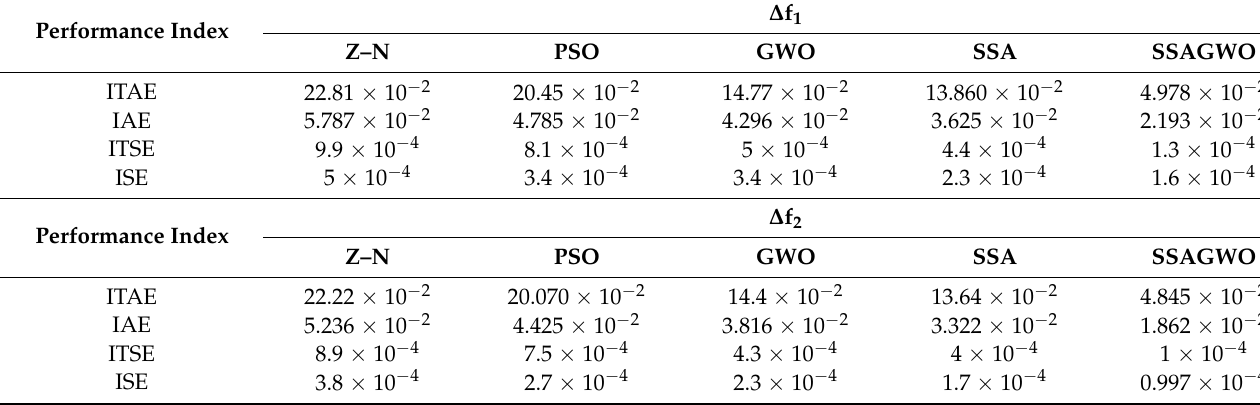
Table 5. Steady-state indices in case